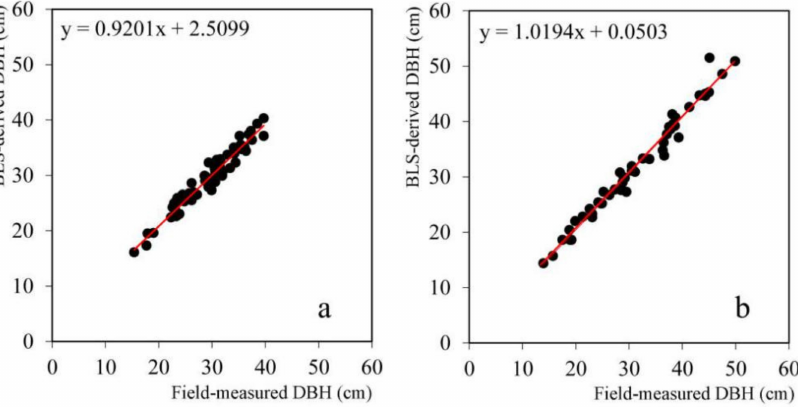
Figure 4. Scatterplots of the BLS-derived and field-measured DBH. ( a ) Dawn redwood, ( b ) poplar. Table 4. Assessment of the accuracy of the tree height and DBH extracted from LiDAR data. Dawn Redwood